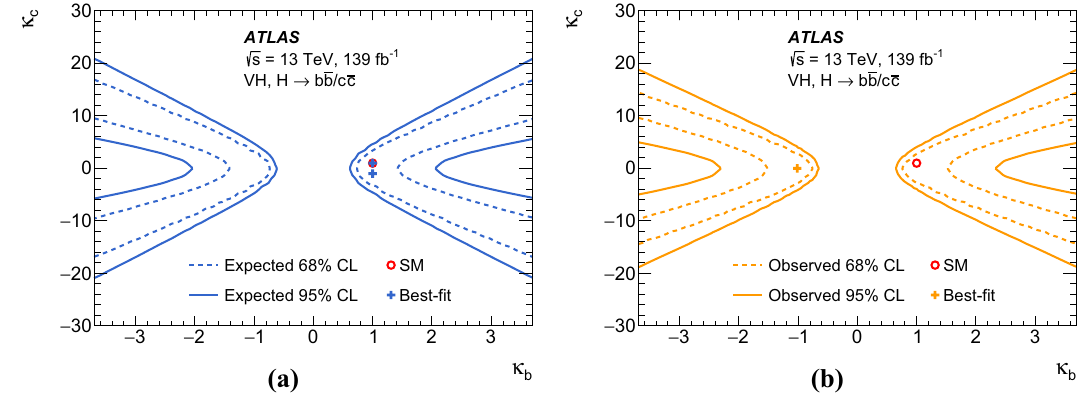
Fig. 6 The a expected and b observed constraints on κ c and κ b at 68% and 95% confidence levels